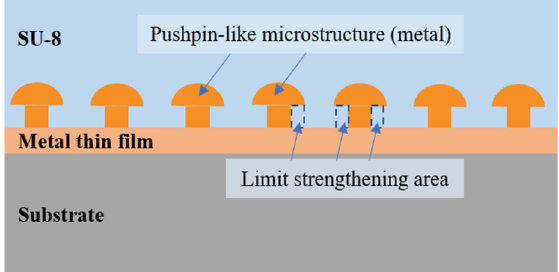
Figure 1. Scheme of enhanced pushpin-like structure array.